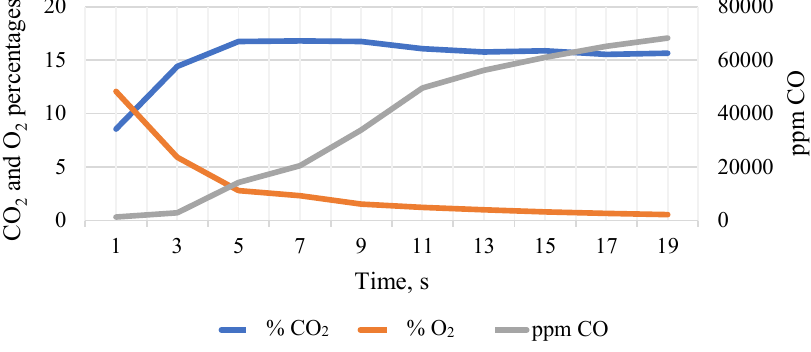
Fig. 3. Emissions Observation